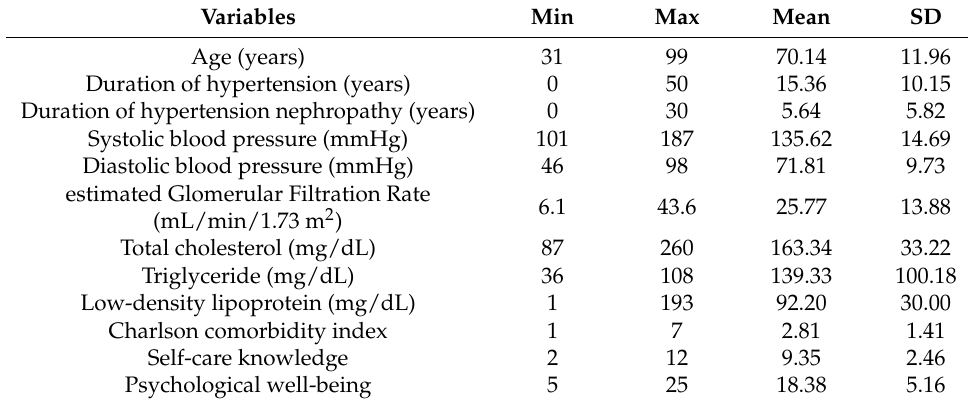
Table 1. Demographic data and disease characteristics of the patients with hypertensive nephrology ( n =